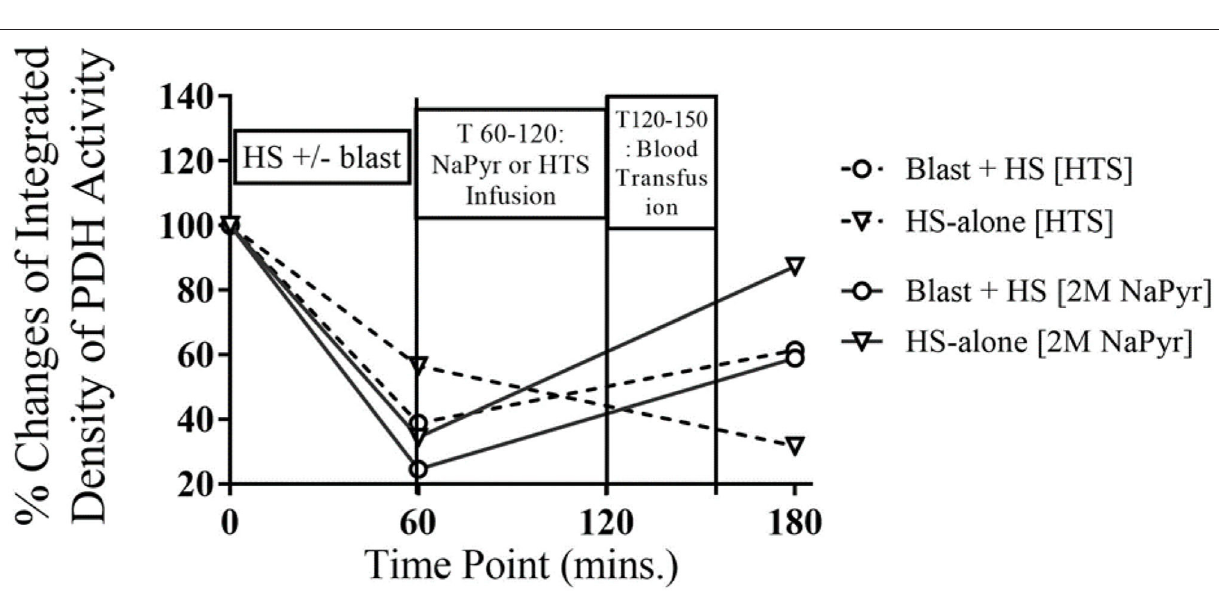
FIGURE 7 | PDH enzyme activity in whole blood at different time-points of HS and/or 20PSI blast injury, and sodium pyruvate (treatment) or hypertonic saline (control) infused animals ( n = 8) surviving for 4h. PDH activity decreased from the baseline value in all injury groups at T60, which was not statistically significant. The PDH enzyme activity greatly improved after sodium pyruvate infusion, which was dependent on the severity of the injury. Sham animals did not show any changes that has not been mentioned